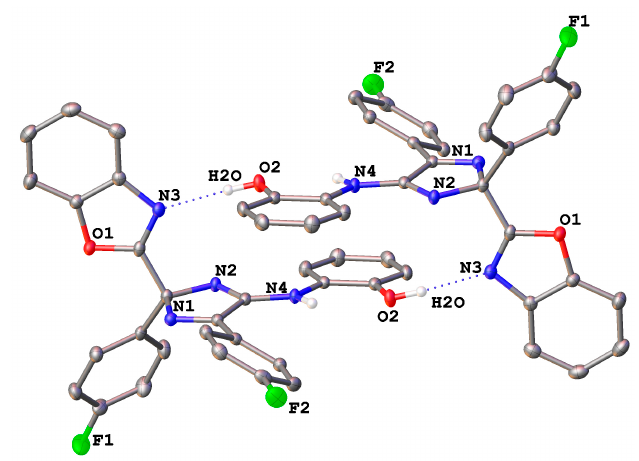
Figure 5. O-H···N and stacking bonded centrosymmetric dimer in the crystal of 10b . Mechanistic Rationale